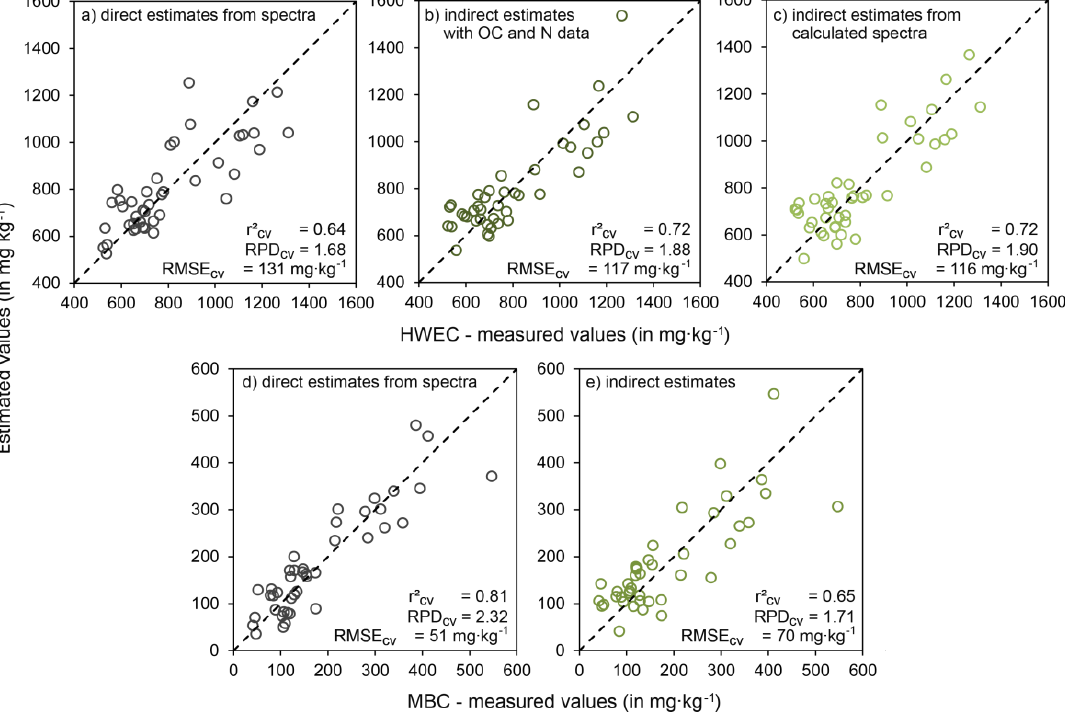
Figure 7. Scatterplots of measured vs. estimated values of HWEC ( a – c ) and MBC ( d , e ) (cross-validated results, n = 42), in which estimates were obtained with ( a , d ) PLSR and pooled selected variables based on measured FOSS spectra; ( b , e ) linear regression based on wet-chemical data of OC and N; and ( c , e ) PLSR and calculated FOSS spectra that were perfectly fitted to OC and N values (results of both indirect approaches matched perfectly for MBC).